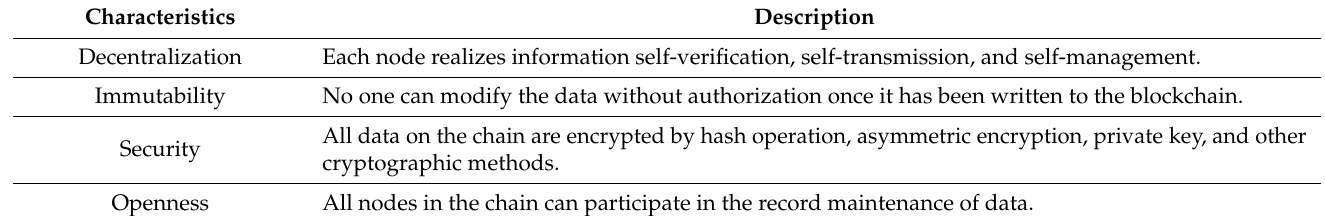
Table 1. The characteristics of blockchain [3,4,6–9].